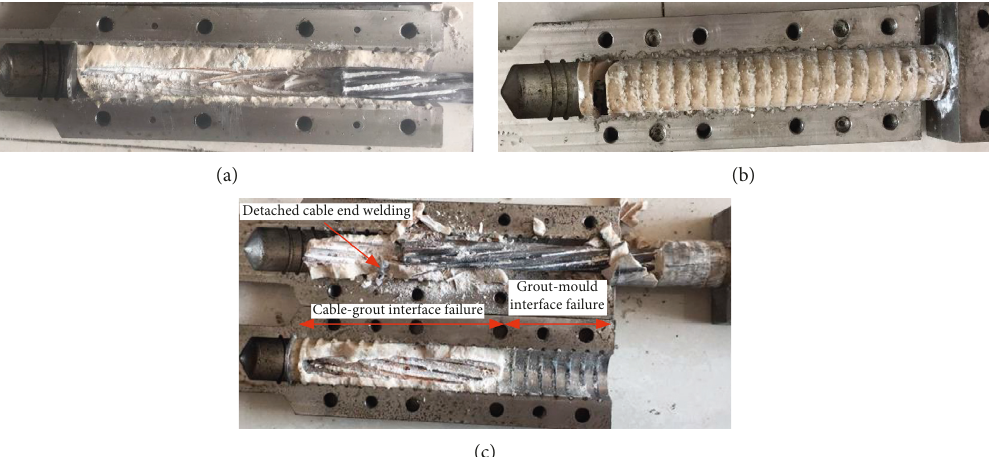
Figure 10: Three failure modes encountered in the DEPTs. (a) Typical cable-grout interface failure. (b) Grout-mould interface failure. (c) Cable end welding failure +partial grout-mould interface failure.